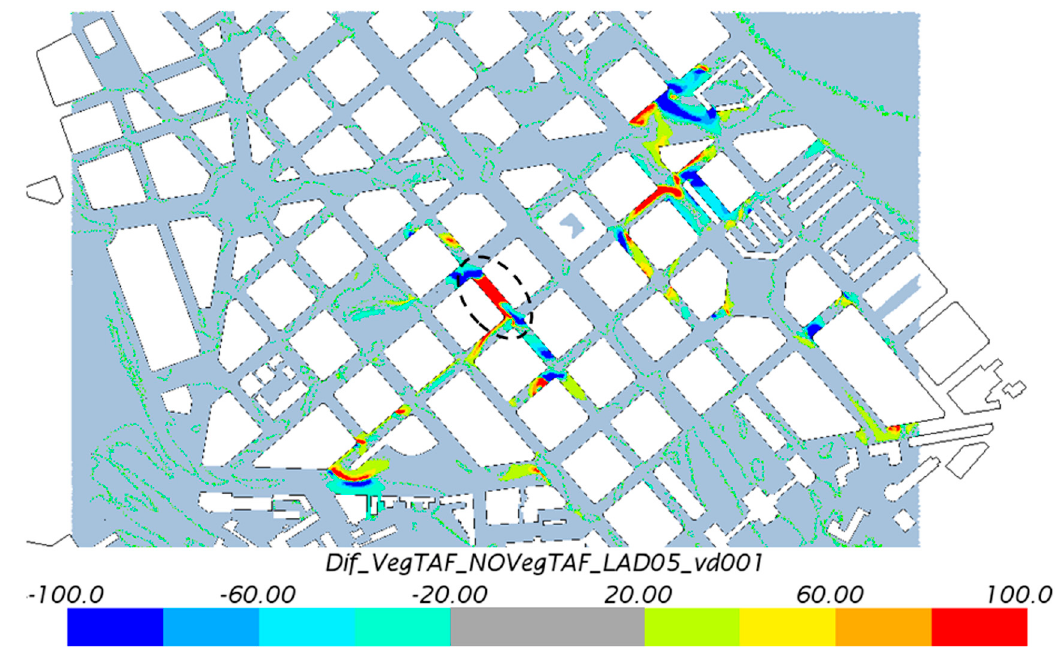
Figure 12. Concentration map for New-2c case.